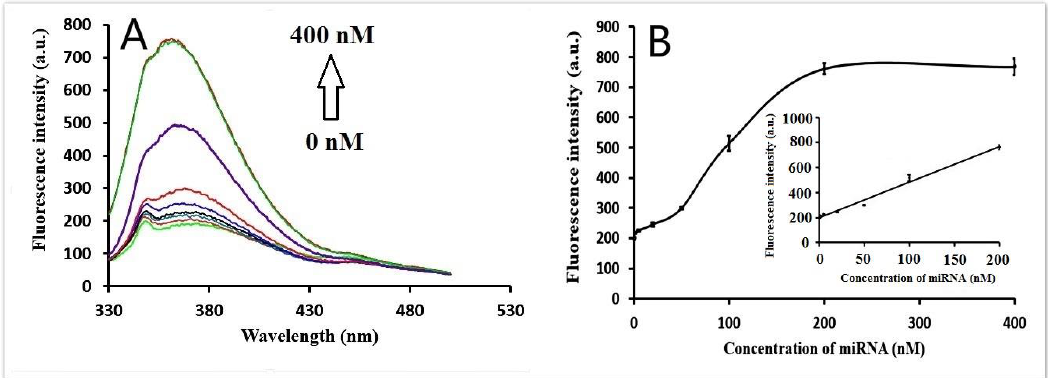
Figure 4. ( A ) Fluorescence emission spectra in the presence of increasing amounts of miRNA (0, 0.5, 1, 5, 20, 50, 100, 200, 400 nM). ( B ) Plot showing changes in fluorescence intensity with miRNA concentration. Inset: graph showing linear relationship of fluorescence intensity with miRNA concentration at low concentration range; 200 nM HP and 20 U/mL exo I were used. Error bars were estimated from three replicate measurements.